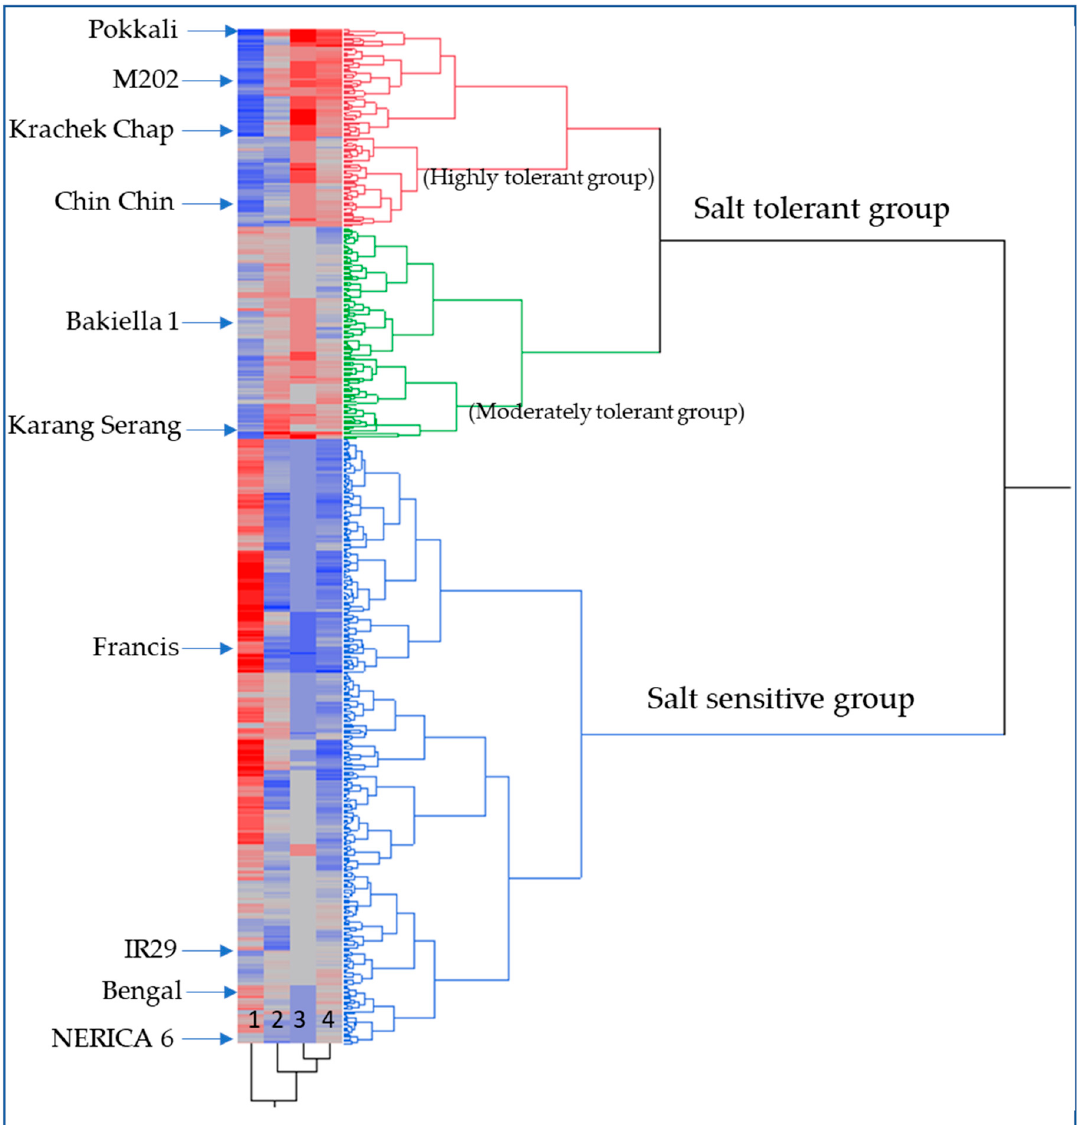
Figure 1. Two-way phenotypic dendrogram showing three clusters for variation in salt tolerance among 162 rice accessions including 123 URMC accessions. Four early vigor traits associated with salt stress tolerance at the seedling stage were used for constructing the dendrogram and are denoted by numbers: 1: SSI score d16; 2: Δ PHT d16; 3: Δ green leaf#; and 4: Total biomass plant − 1 on the x-axis of the heatmap. The blue color illustrates low values, while the red color illustrates high values for the measured trait.